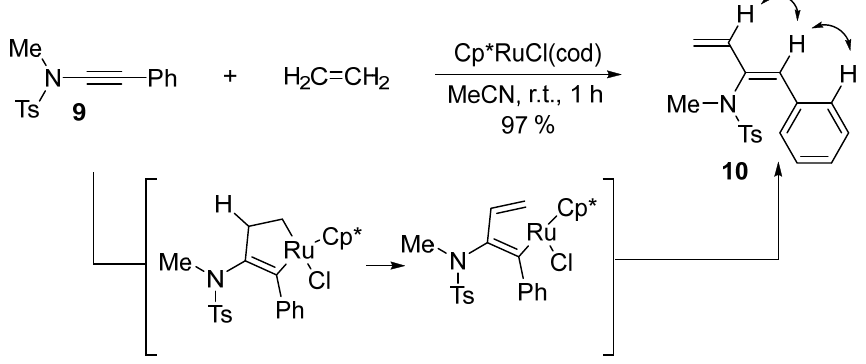
Scheme 7. Mechanism for the reaction described by